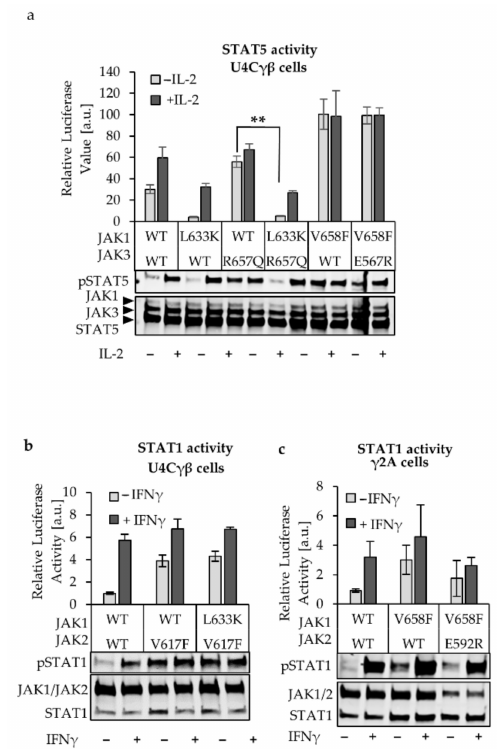
Figure 4. JAK1 L633K e ff ect in trans. ( a ) JAK1 L633K reduces hyperactive JAK3 R657Q while homologous JAK3 E567R cannot reduce JAK1 V658F-driven activation. Both the transcriptional activity and the phosphorylation status of STAT5 were studied as previously described. Normalized SPI-Luc luciferase signal shows averages and SD of six experiments. HA- and pSTAT5 antibodies were used to detect the expression of JAKs and the STAT5 / pSTAT5 ratio of non-stimulated and stimulated (100 ng / mL IL-2) cells. **—indicates p < 0.001 (two-tailed t -test) ( b ) JAK1 L633K does not e ffi ciently inhibit JAK2 V617F driven STAT1 activation. JAK1 WT or L633K were transiently transfected with JAK2 V617F, and STAT1 (IFN γ ) responsive IRF-GAS plasmid was used to detect the STAT1 activity as described earlier. Errors are SD of triplicate samples. Below: whole cell lysates from unstimulated (basal-state) cells transfected with JAK1 and JAK2 and labelled with HA and pSTAT1 antibodies. The blots are representative of three experiments. ( c ) JAK2 E592R inhibits JAK1 V658F-driven STAT1 activation. JAK2 WT or E592R were transiently transfected with JAK1 V658F and STAT1 (IFN γ ) responsive